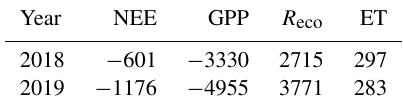
Table 3. Net ecosystem exchange of CO 2 (NEE, gCO 2 m − 2 ), its components gross primary production (GPP) and ecosystem respi- ration ( R eco ), and evapotranspiration (ET, mm) during the growing season (4 May to 30 September) in 2018 and 2019. Year NEE GPP R eco ET 297